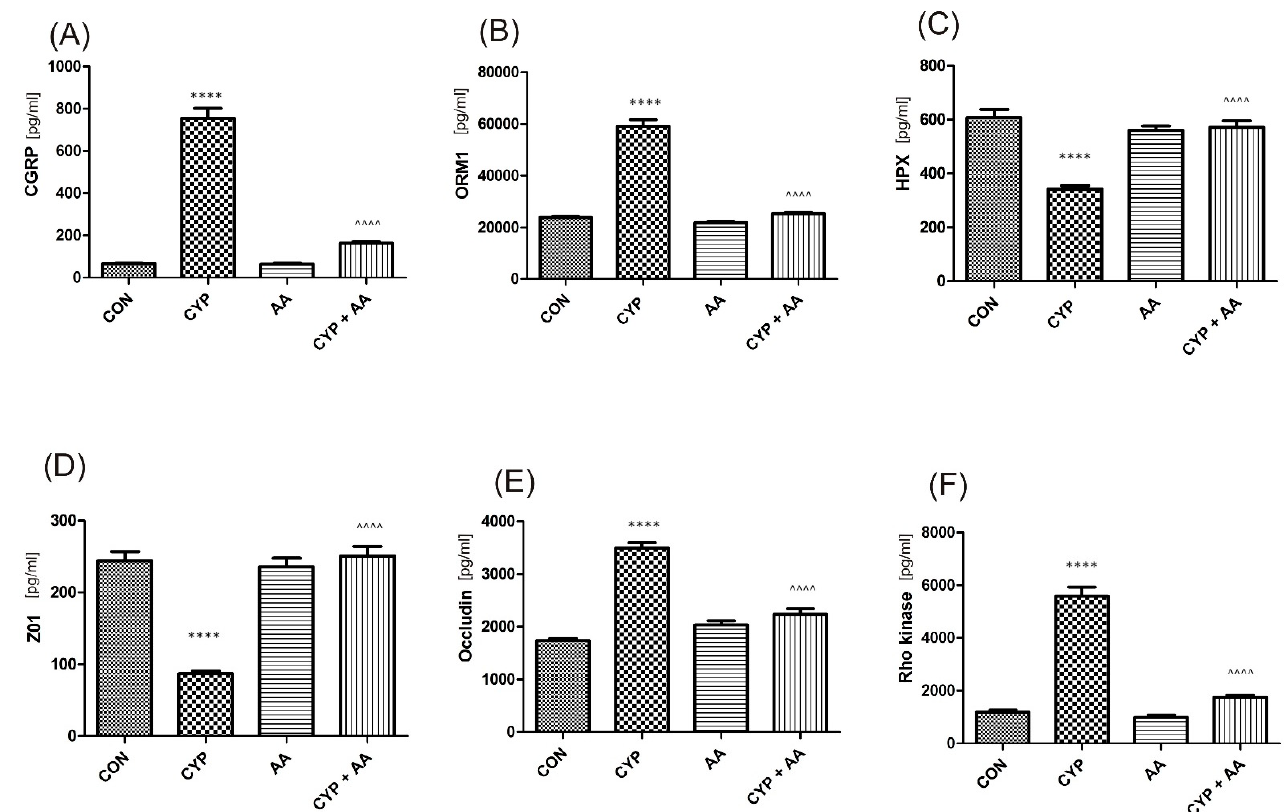
Figure 2. The effect of the two-week administration of asiatic acid (30 mg/kg/day for 14 days by oral gavage) on biomarkers in urothelium or in bladder detrusor muscle: ( A ) calcitonin gene related peptide (CGRP), ( B ) orosomucoid-1 (ORM1), ( C ) hemopexin (HPX), ( D ) tight junction protein 1 (ZO1), ( E ) occludin (OCC), and ( F ) Rho kinase (ROCK1) in animals that were administered with a single injection of cyclophosphamide (CYP, 200 mg/kg, intraperitoneally). All results are presented as the mean ± SEM (n = 15 rats per group). The obtained data were assessed by the one-way ANOVA followed by Tukey’s post hoc test. * when significantly different from the control group. ^ when significantly different from the CYP group. **** or ^^^^ p < 0.0001. One-way ANOVA: for CGRP F(3.56) = 185, p < 0.0001, for ORM1 F(3.56) = 176, p < 0.0001, for HPX F(3.56) = 29, p <0.0001, for ZO1 F(3.56) = 49, p < 0.0001, for OCC F(3.56) = 82, p < 0.0001, and for ROCK1 F(3.56) = 131, p < 0.0001. AA: asiatic acid; CON: control; CYP: cyclophosphamide.